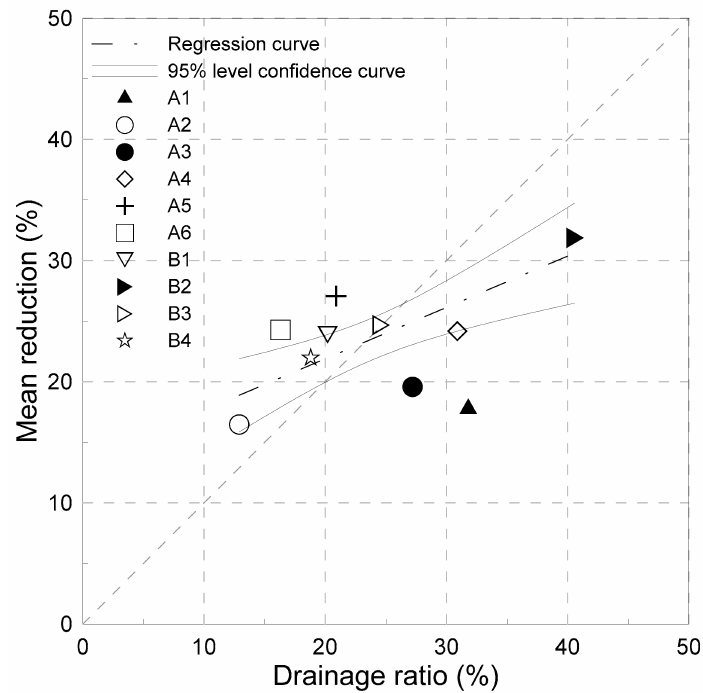
Figure 9. Mean runoff reduction by drainage ratio (drainage area/LID drainage area × 100%) from the long-term simulation. In the lowest annual precipitation case (2015 year, 751.1 mm), the total runoff reduction rate was highest (33.2%), while the lowest rate was 19.6% in 2011. The monthly rate of reduction was low during the wet season (averaging 14.6%), and high during the dry season (averaging 31.7%), suggesting that seasonal runoff depends on the magnitude of seasonal